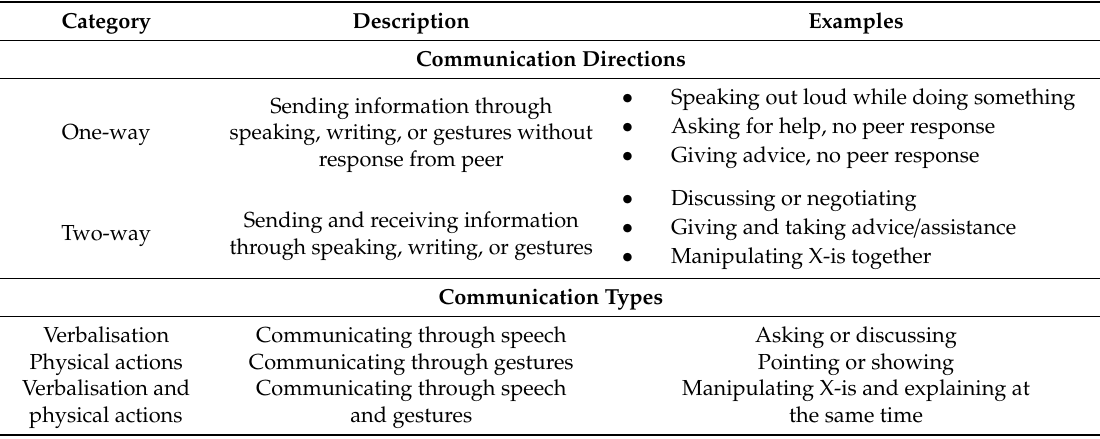
Table 2. Categories for communication directions and